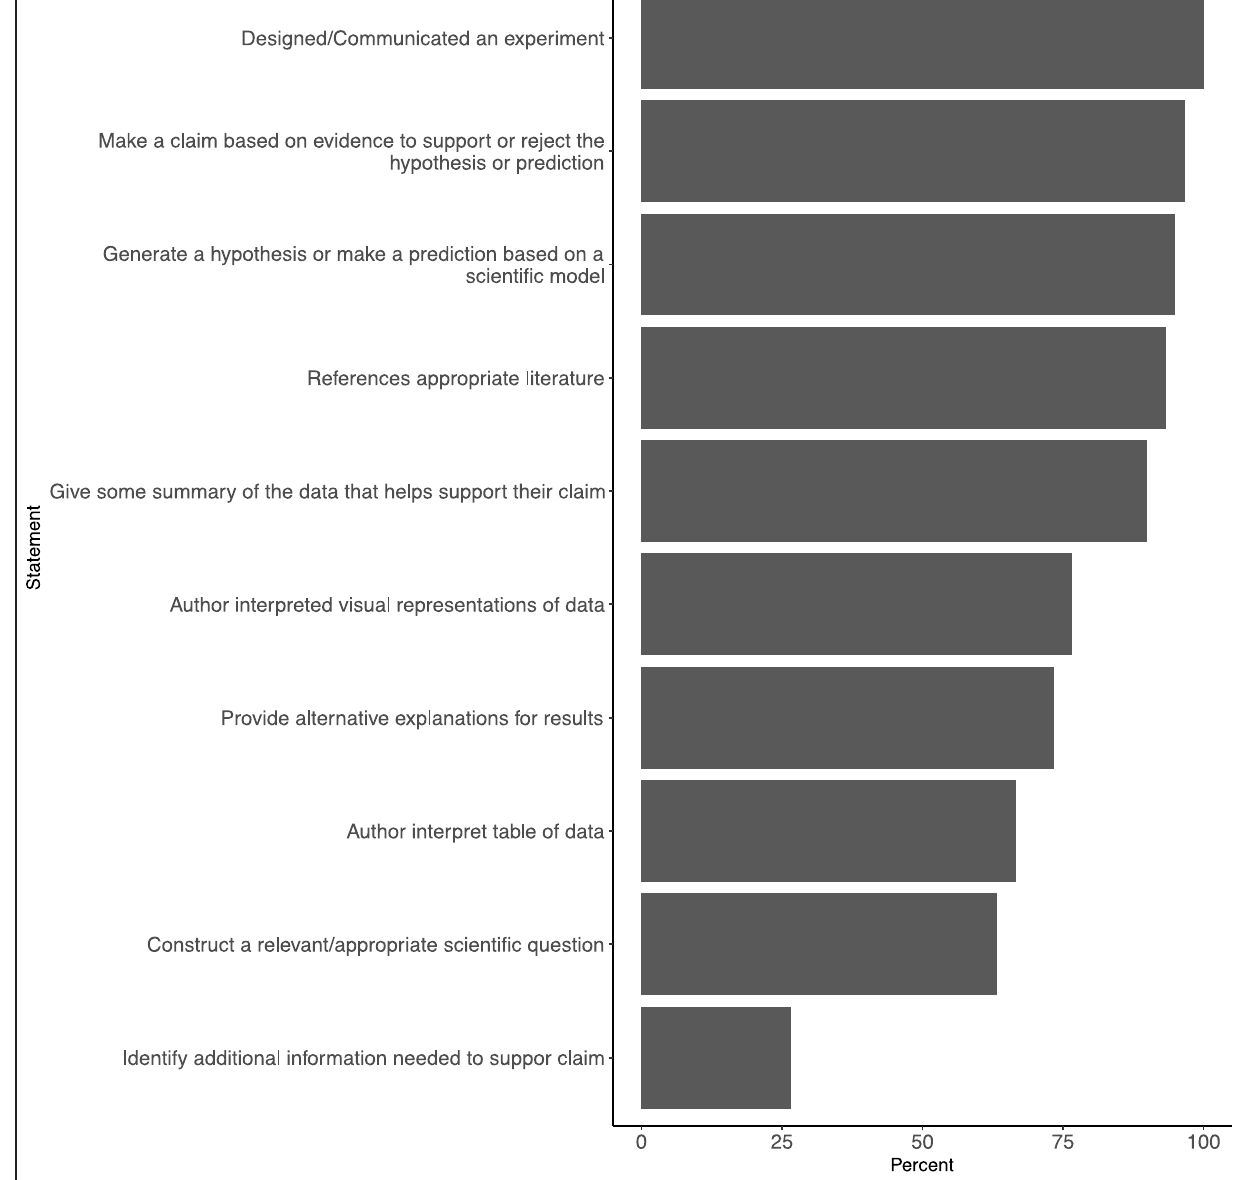
Figure 2 Percentage of students who included different skills for experimental design, interpretation of data, and derivation of conclusions in their individual